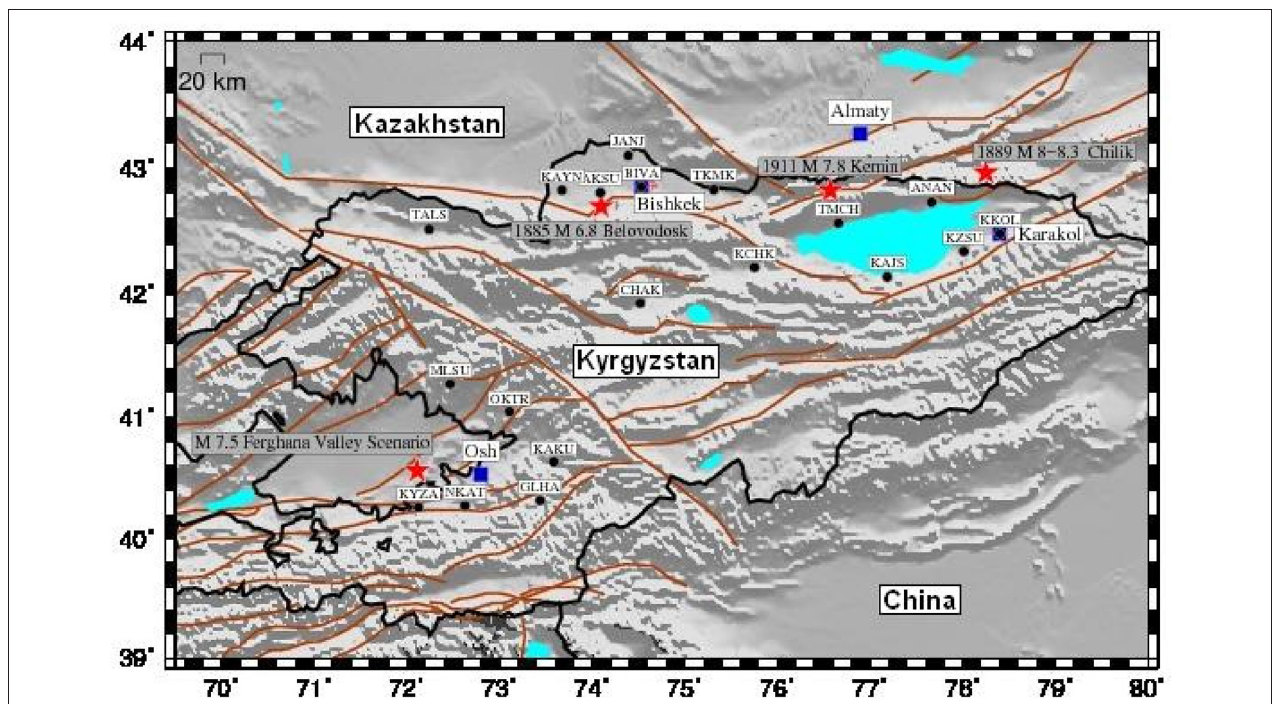
FIGURE 1 | The location of the current stations of the ACROSS network (black circles). Also shown are the main cities (blue squares) and the epicenters of a selection of historical or hypothetical earthquakes (see the text for explanation) considered in this study (red stars). The brown lines indicate the main tectonic alignments and faults identified in this